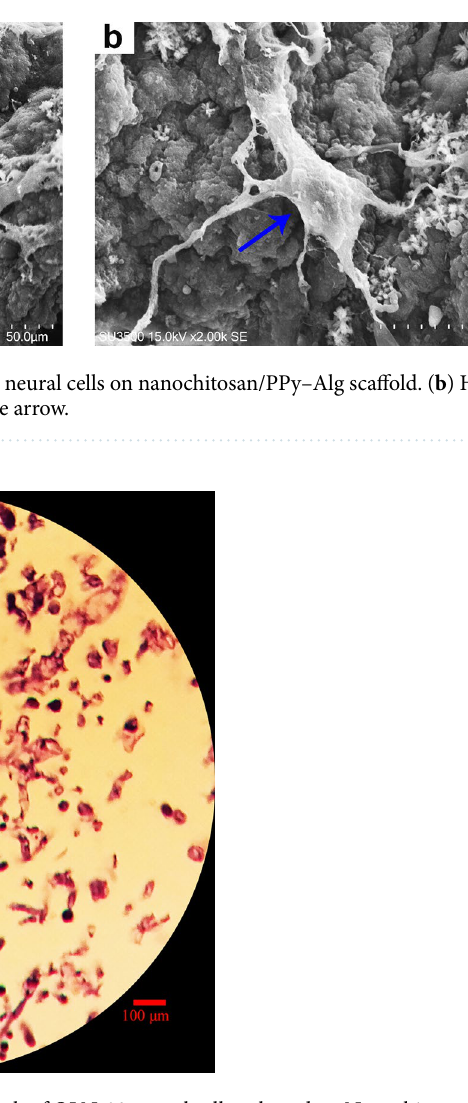
Figure 8. H&E staining optical micrograph of OLN-93 neural cells cultured on Nanochitosan/PPy–Alg scaffold for 24